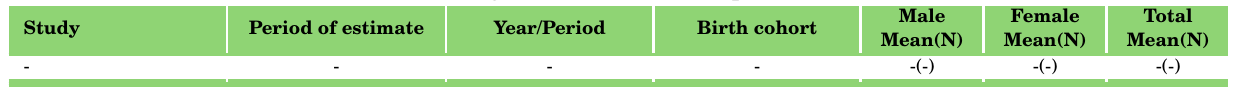
Table 43: Average number of sexual partners in